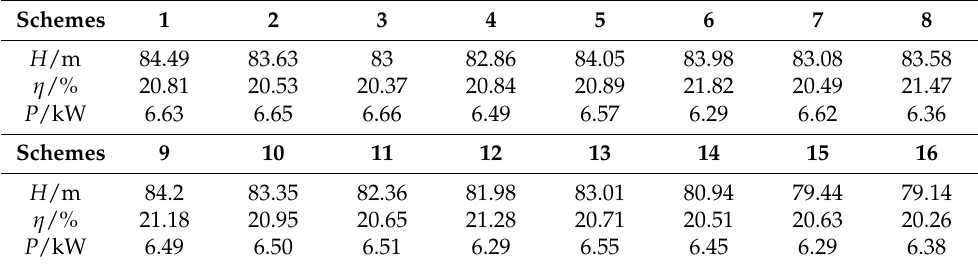
Table 3. Numerical simulation results at 0.6 Q des